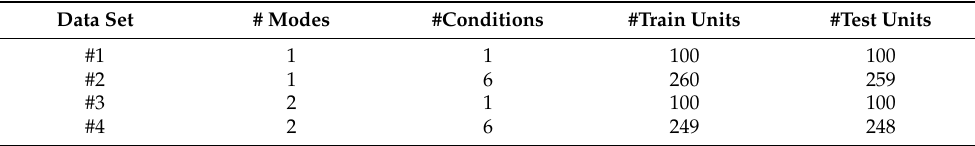
Table 4. Characteristics of the four turbofan engine datasets, note that the difference between the four datasets lies within the number of fault modes (’modes’) and operating conditions (’conditions’). Data Set # Modes #Conditions #Train